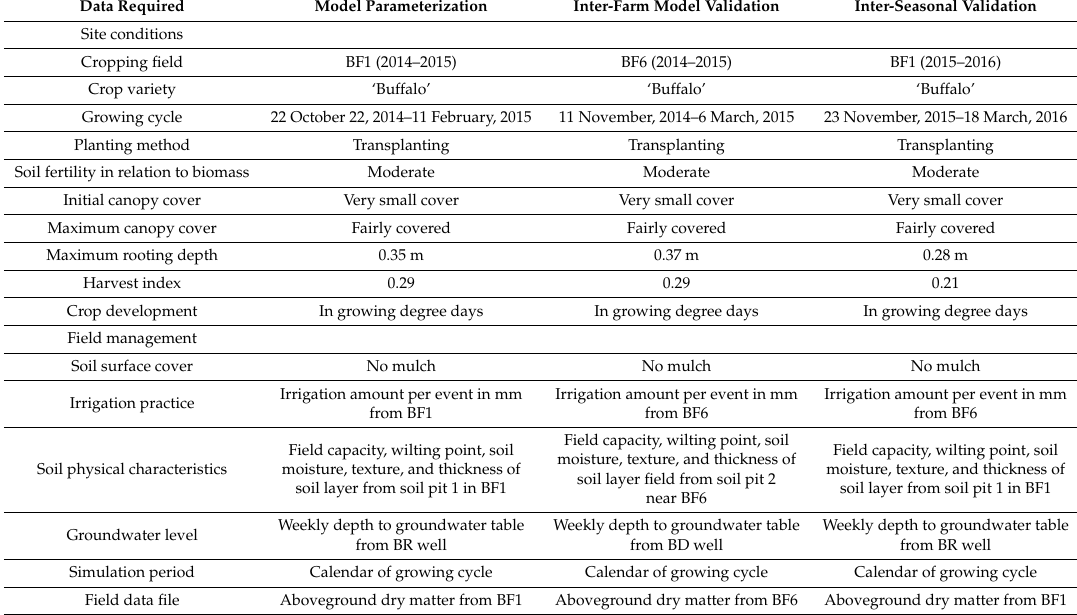
Table 2. Modified parameters and field data for the parameterization and validation of the AquaCrop model for